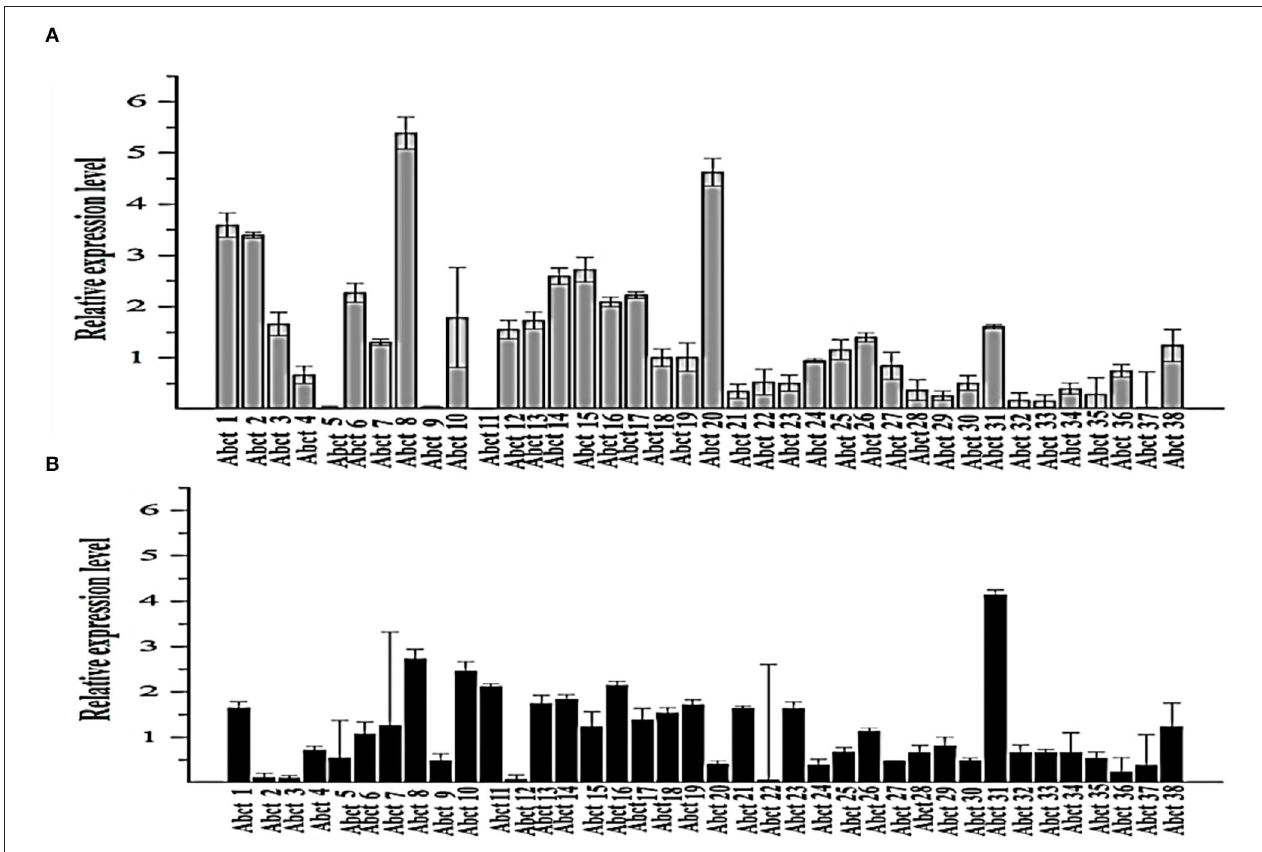
FIGURE 1 | Quantitative real-time PCR analysis of the expression of all ABC transporter genes in the M. ruber M7 toward PAA. (A) The comparative expression of all ABC transporter genes in M. ruber M7 without PAA; (B) A comparative expression of all ABC transporter genes in M. ruber M7 with PAA. M. ruber M7 was cultivated and incubated at 28 ◦ C for 7 d in the presence (black bar) and absence (gray bar) of PAA at 10mM. The values were represented as average values ±